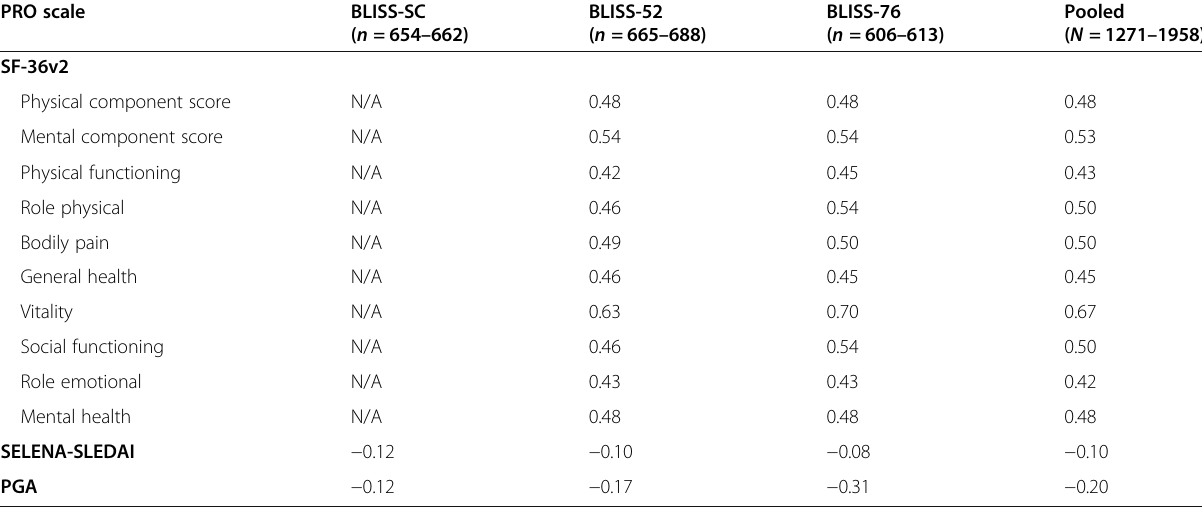
Table 5 Spearman correlations between change from baseline in FACIT-Fatigue and various measures (Week 52) PRO scale